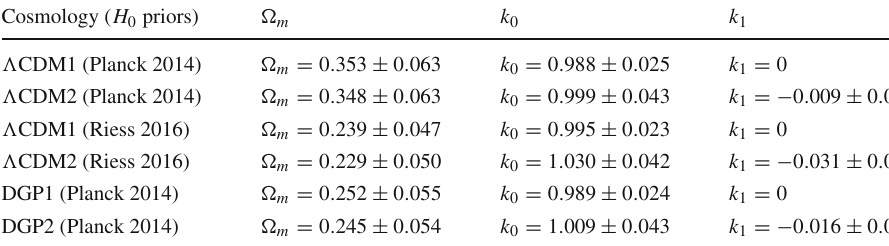
Table 2 Constraint results obtained by the quasar sample for the flat (cid:3) CDM and DGP